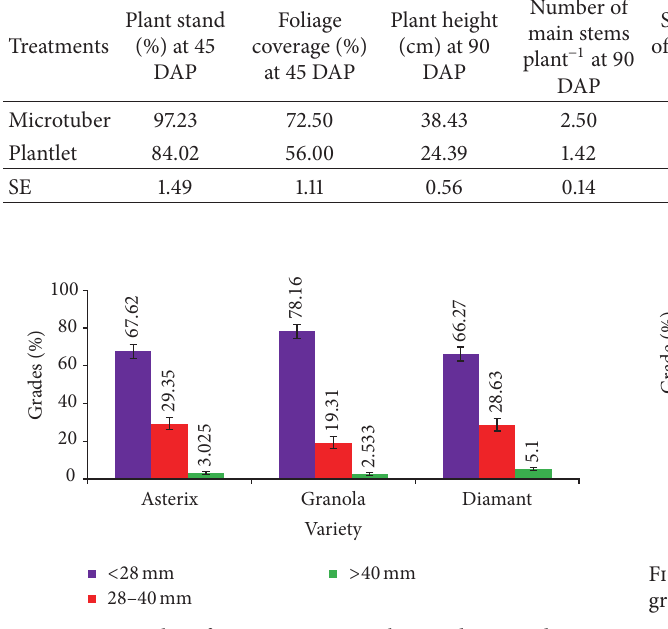
Figure 1: Varietal performance on minituber grades according to size.